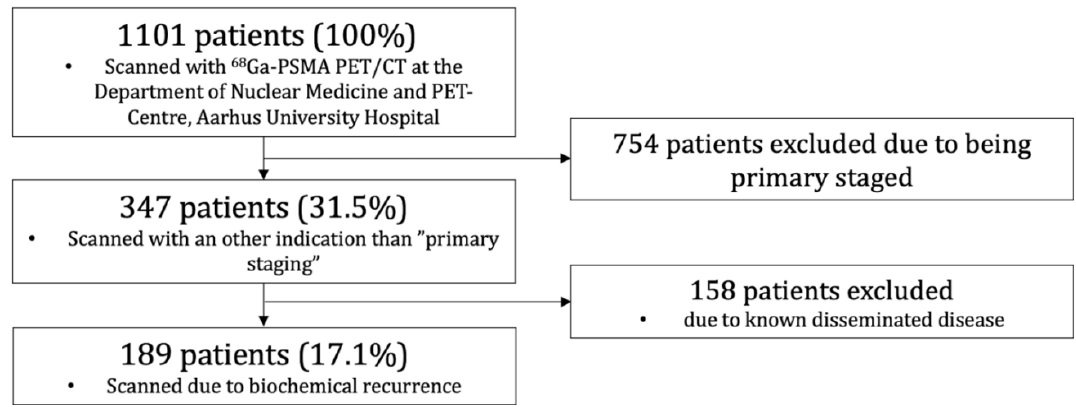
Figure 1. Study flow for 68 Ga-PSMA PET/CT of patients with biochemical recurrence.